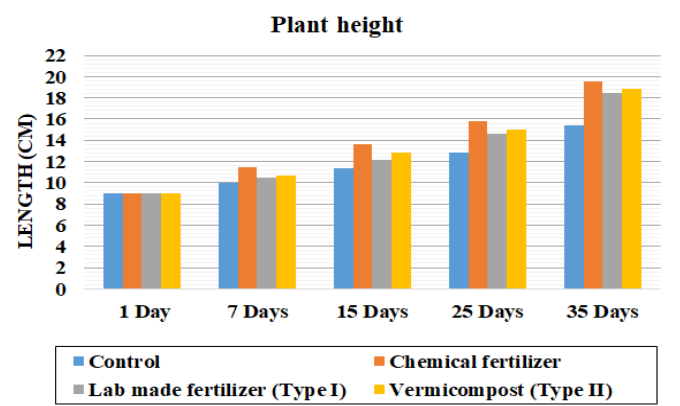
Figure 7. Effect of by different fertilizer on plant growth in terms of plant